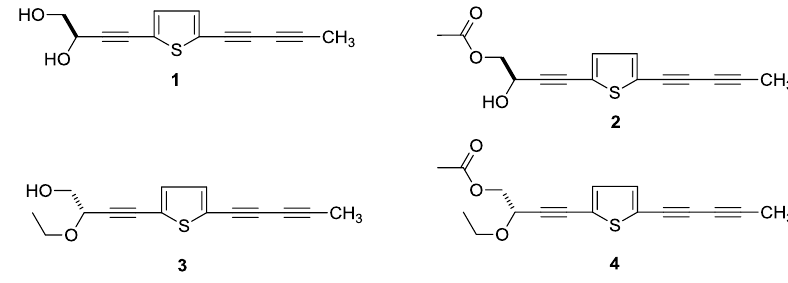
Figure 1. The new compounds 1 – 4 obtained from the aerial parts of P. indica .